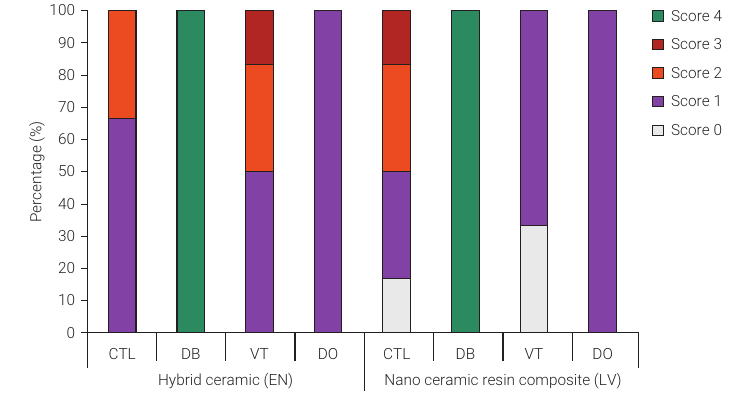
Figure 3. Scores attributed in different